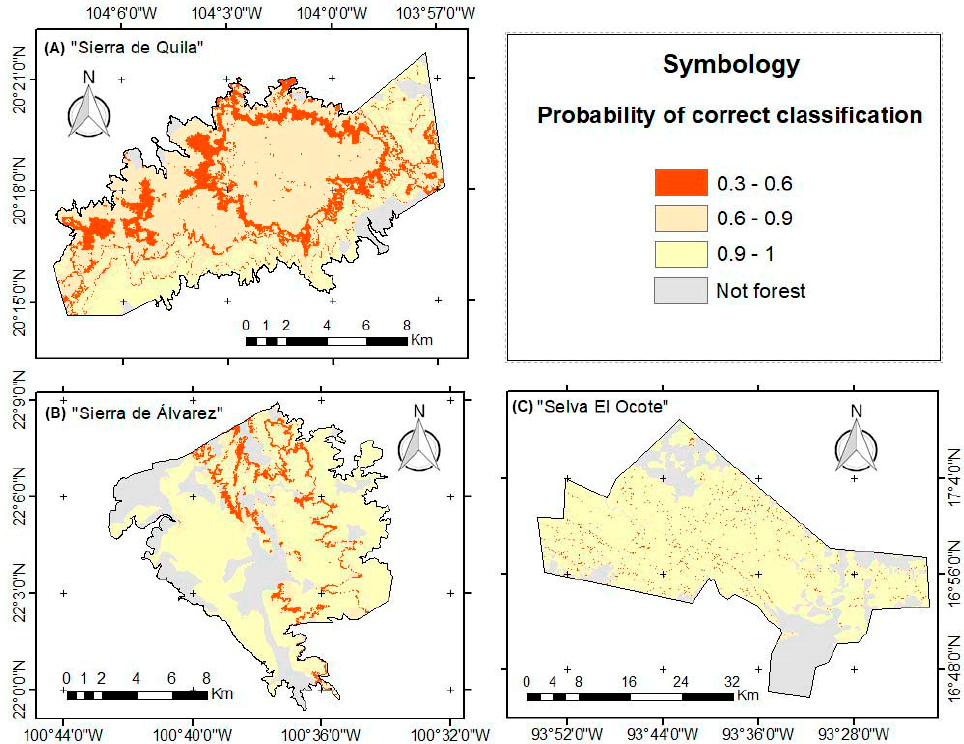
Figure 5. Probability maps resulted from classification analysis; ( A ) “Sierra de Quila,” ( B ) “Sierra de Álvarez,” and ( C ) “Selva El Ocote”.